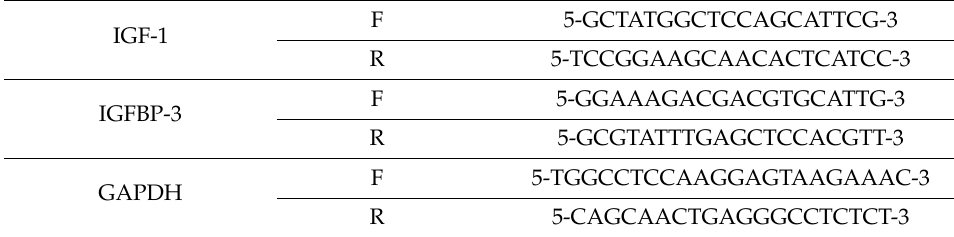
Table 1. The primer sequences used in the real-time quantitative polymerase